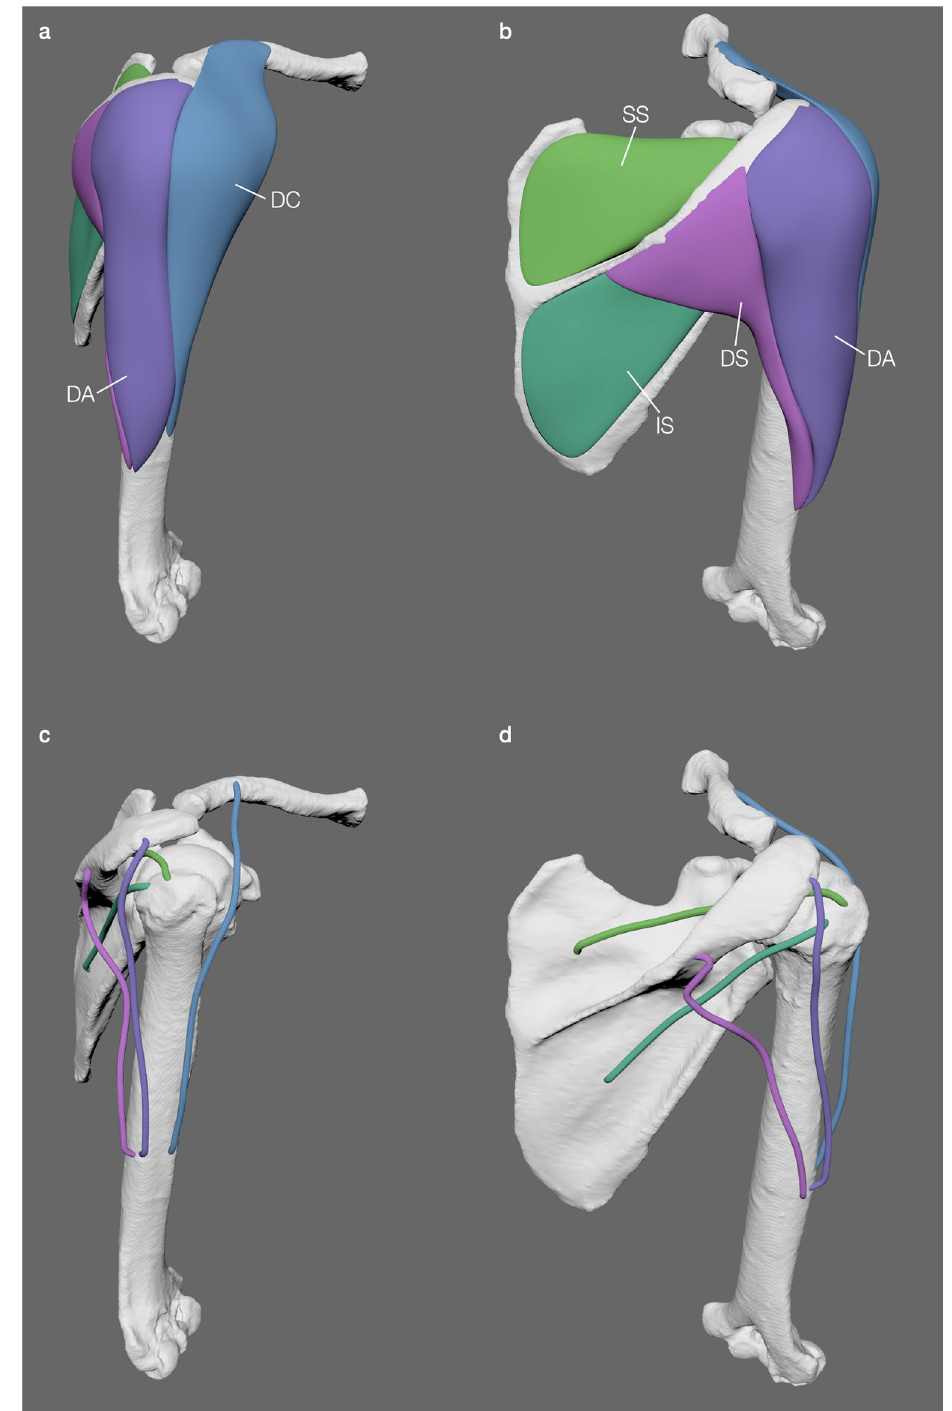
Figure 3. Muscle modelling and LoA estimation of the gorilla shoulder. 3D volumetric muscle models ( a , b ) and estimated LoAs ( c , d ) in lateral view ( a , c ) and dorsal view ( b , d ) respectively. Abbreviations: DA, M. deltoideus acromialis ; DC, M. deltoideus clavicularis ; DS, M. deltoideus spinalis ; IS, M. infrapspinatus ; SS, M. supraspinatus